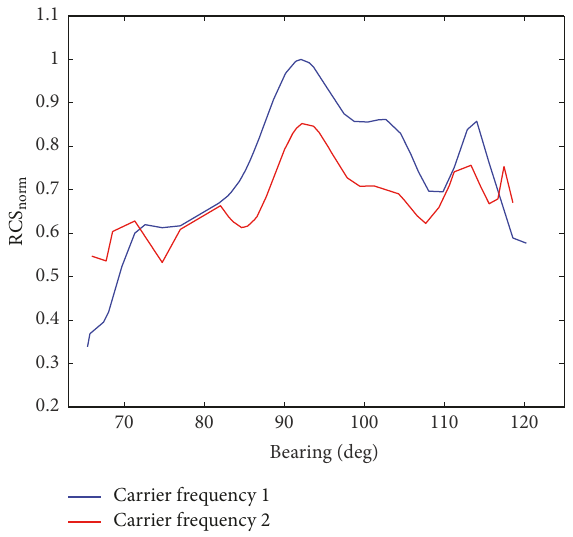
Figure 3: RCS versus bearing at two frequencies for one